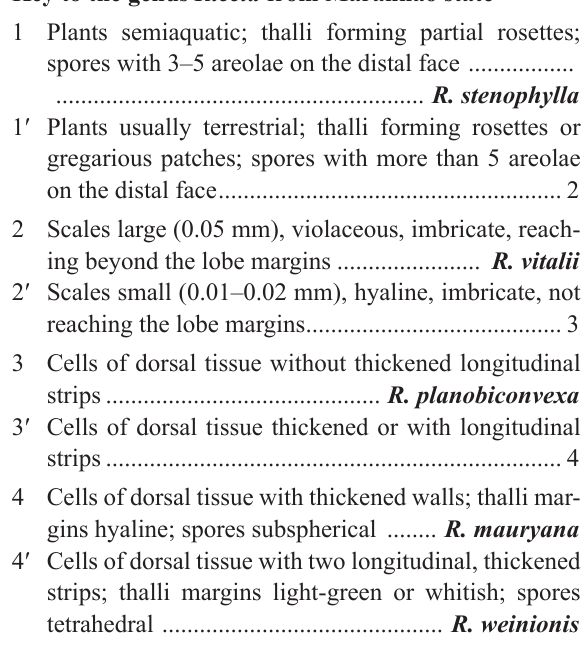
Material examined. Brazil: Maranhão: Chapadinha, Capitão de Campo, periodically flooded area, partly exposed to the sun, 03°44 ʹ 30 ʺ S, 043°21 ʹ 37 ʺ W, 105 m a.s.l., M.A.F. Rodrigues and A.L.F. Rodrigues, 21 May 2016, 52 (CCAA); Chapadinha, pavement border of the